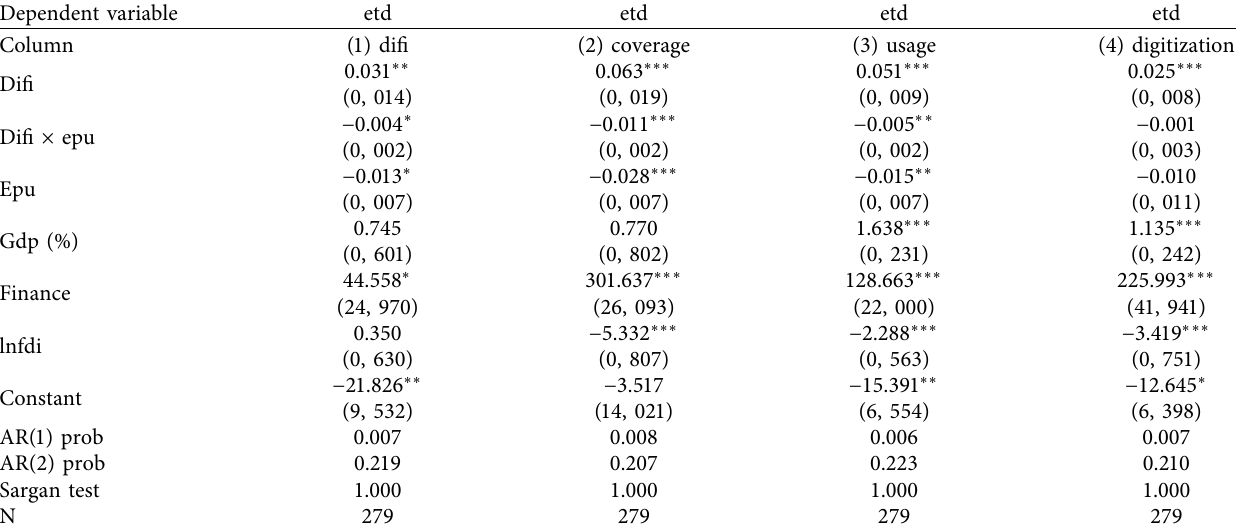
Table 8: Robustness test based on system GMM